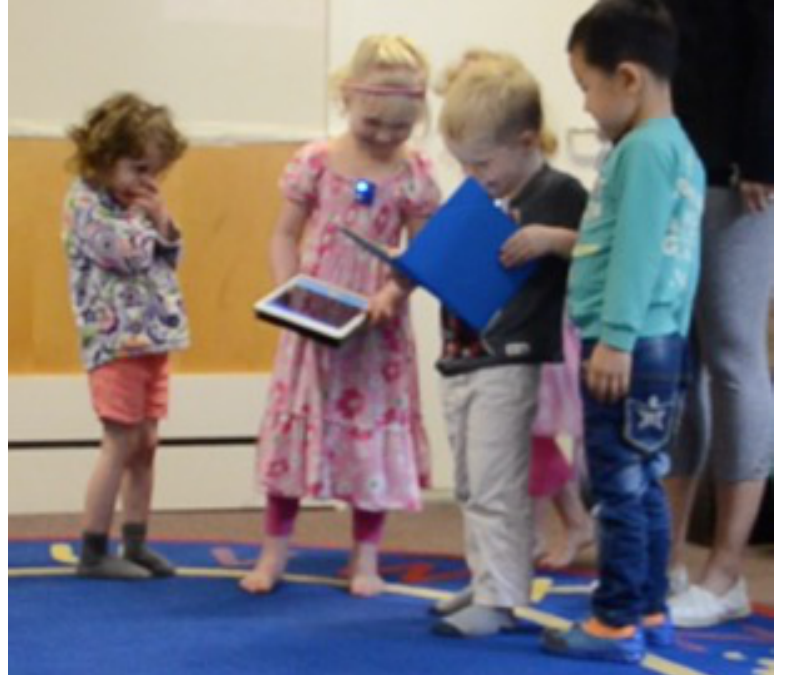
Figure 6. All participants laughing while Participant 4 covers her face